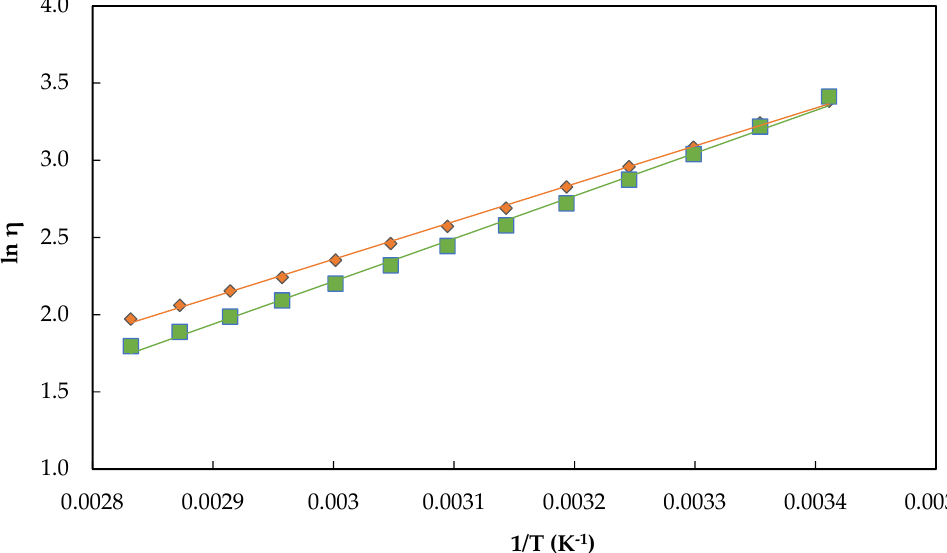
Figure 2. Temperature dependence of the logarithmic experimental viscosities ( η ) for [C 2 mim][CF 3 BF 3 ] ( ) and [C 2 mim][CF 3 SO 2 C(CN) 2 ] ( ). The errors bars are smaller than the symbols used to represent the experimental data.